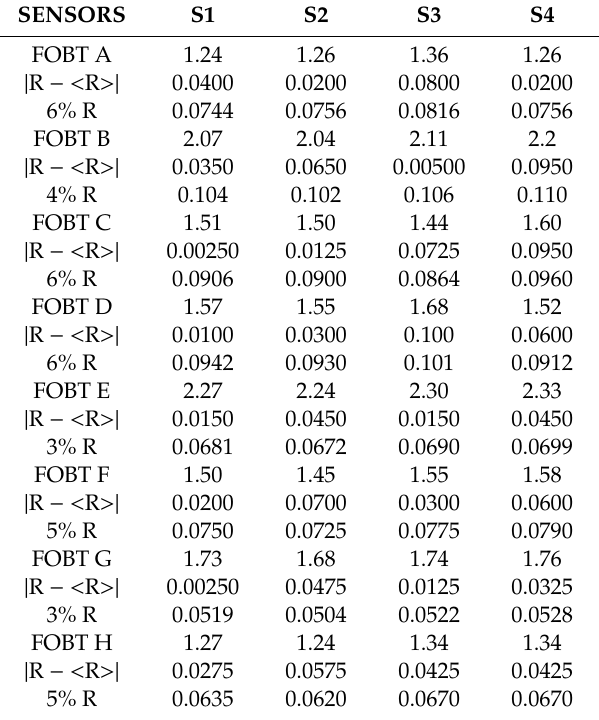
Table 5. Responses R to eight FOBT-positive fecal samples; absolute distance from mean value ( | R − < R >| ); and percentage of R below which the value of | R − < R >| stands for all